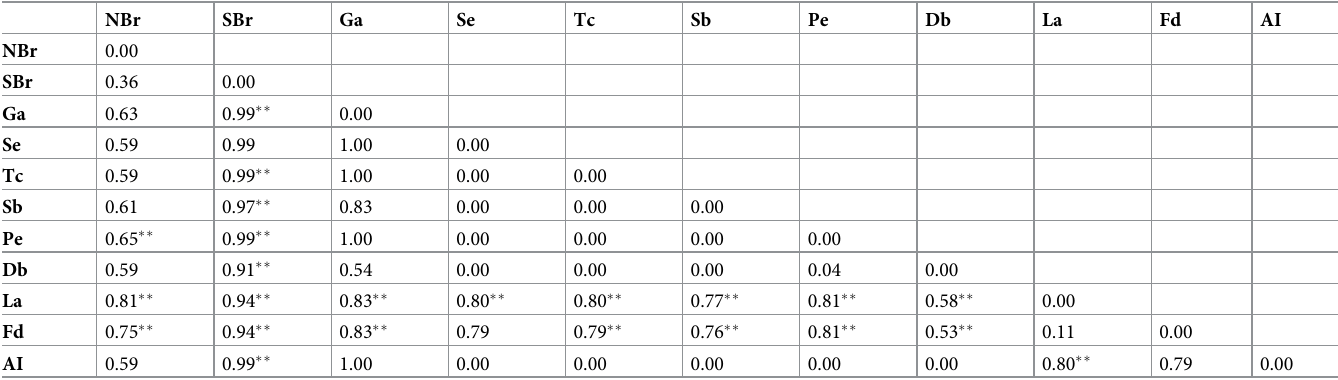
Table 3. Pairwise ϕ ST values between populations of Octopus vulgaris .